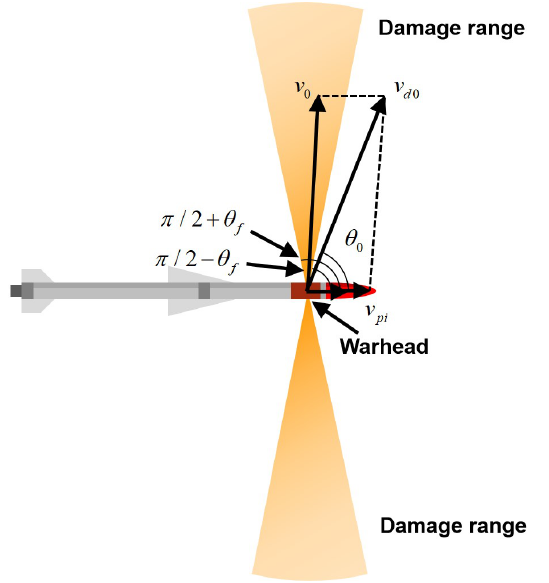
Figure 2. Initial static velocity v d 0 of the fragment in the projectile coordinate